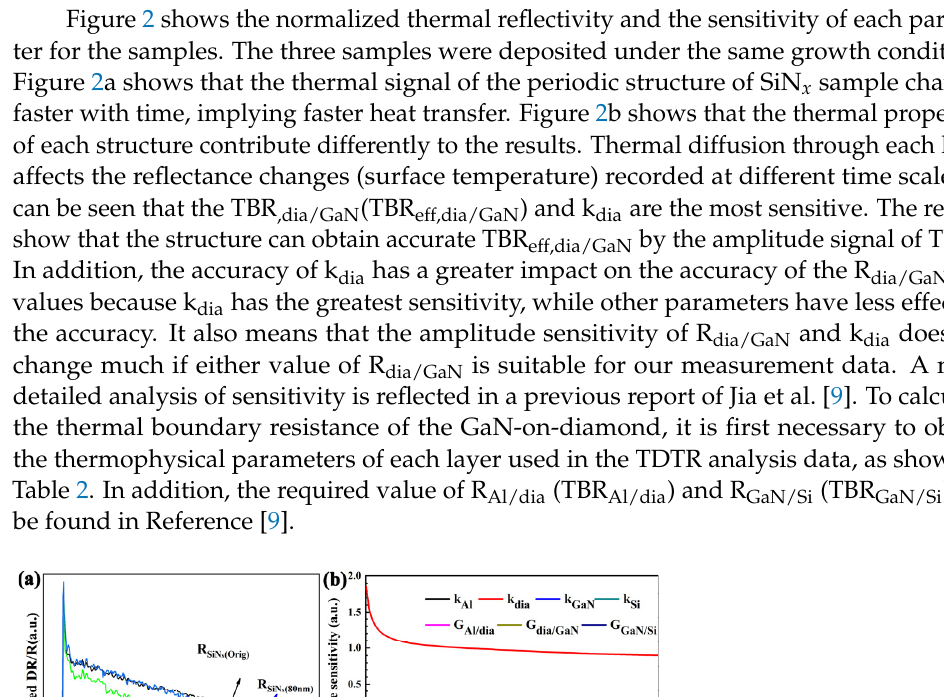
Table 1. SiN x etching process parameters.